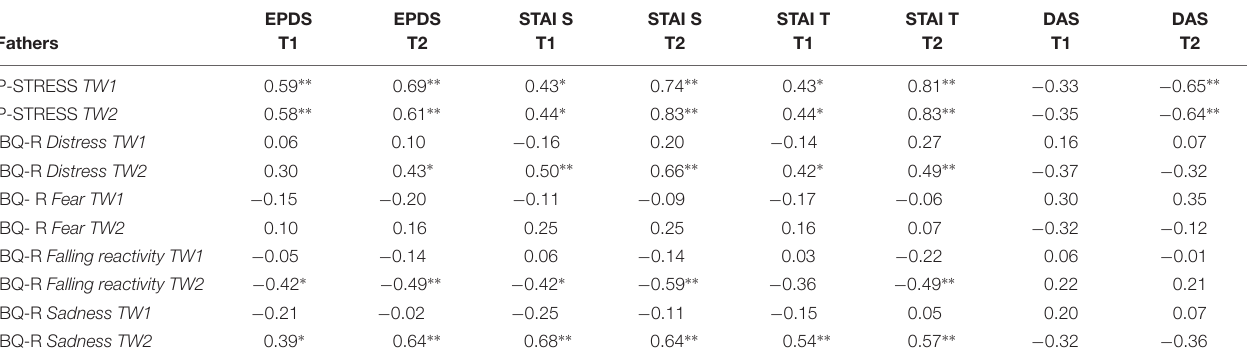
TABLE 3 | Bivariate correlations among study variables for